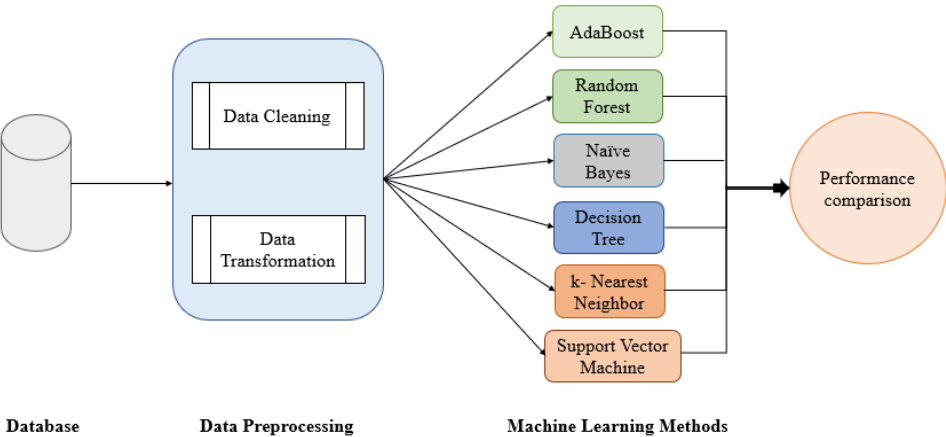
Figure 1. Flow diagram of the study. The diagram shows the first phase of pre-processing the database. Subsequently, the machine learning algorithms described are applied to the pre-processed dataset. In the final phase, the performance metrics obtained from the algorithms are compared.